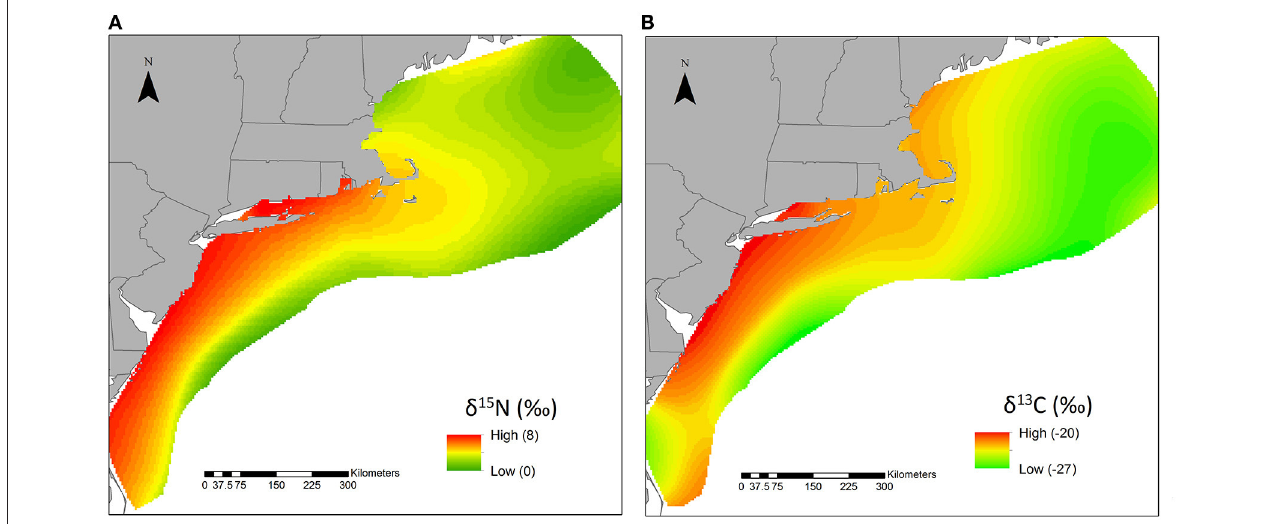
FIGURE 3 | Interpolated surface of particulate nitrogen (A) and carbon (B) stable isotope values across the full study area. The gradient was scaled between the highest and lowest sampled values. The upper and lower bounds of δ 15 N and δ 13 C values were included in the legend to orient the reader. These values and the associated color gradations should not be used to quantify characteristic values for a particular region. Only samples collected from surface waters were included.